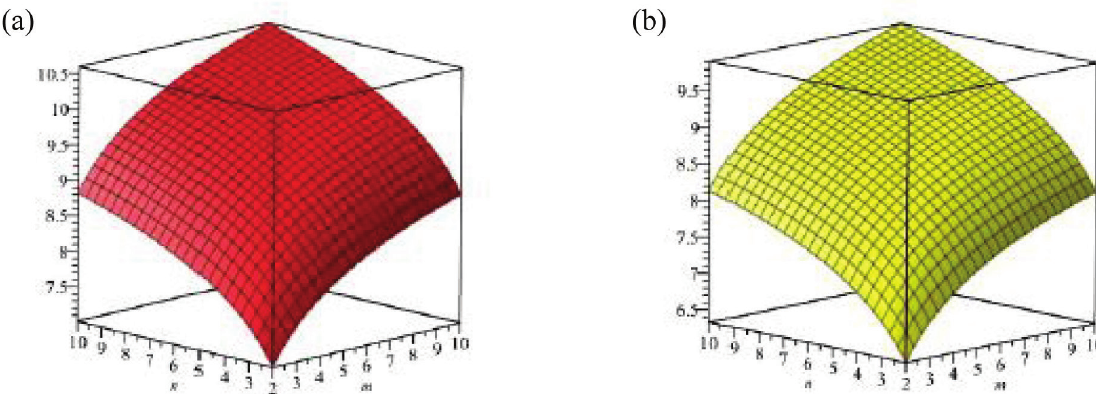
Figure 6: (a) The hyper Zagreb entropy, (b) the forgotten entropy.